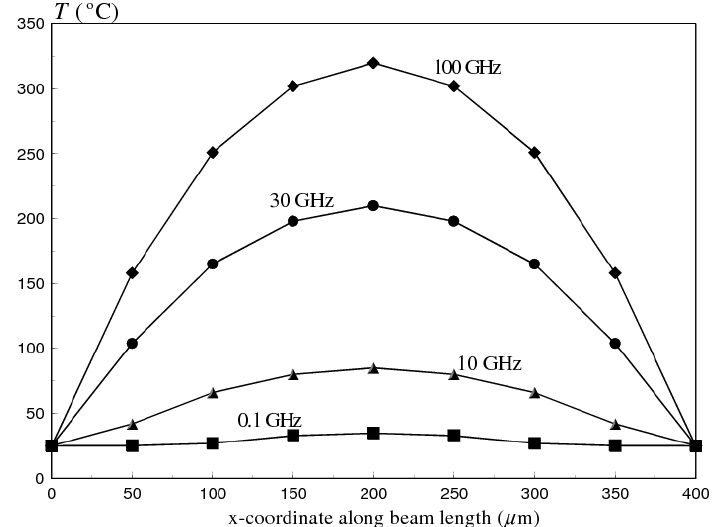
Figure 9. Temperature distribution along membrane length of flat aluminum RF MEMS switch at an operating frequency range of 0.1-100 GHz ( l t = 3 µm , P = 0.75 W) m